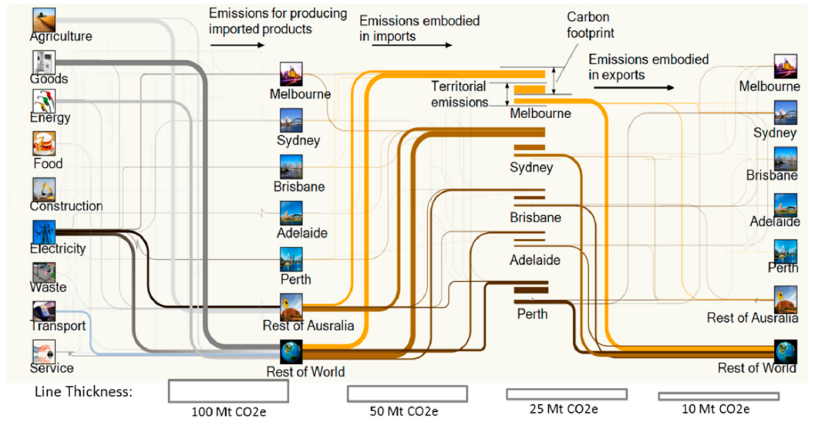
Figure 5. Flows of embodied GHG emissions related to city final demand for services.